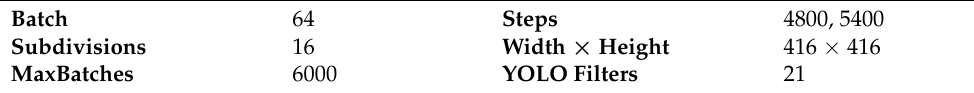
Table 2. Parameter